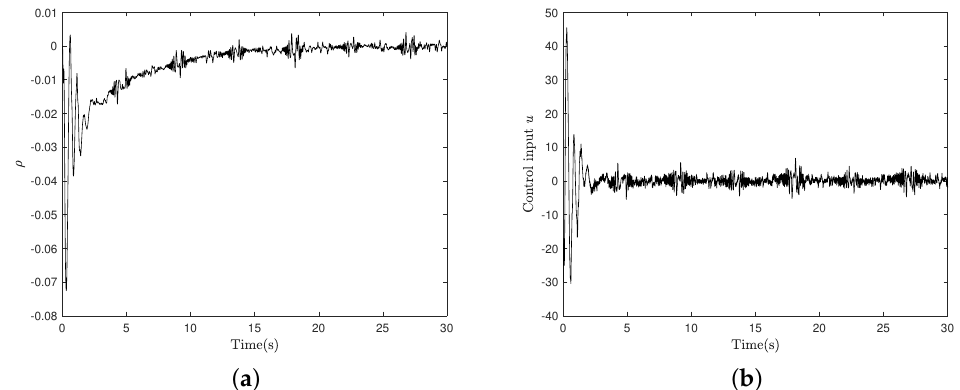
Figure 6. Input delay compensator and control input of the proposed control system for Example 2: ( a ) ρ ; and ( b ) u